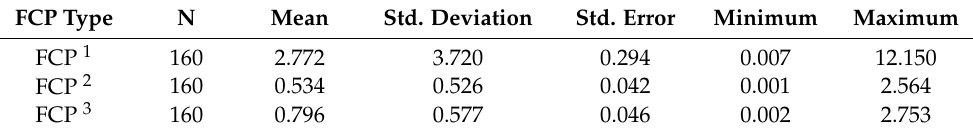
Table 2. Statistics of FCP Errors.